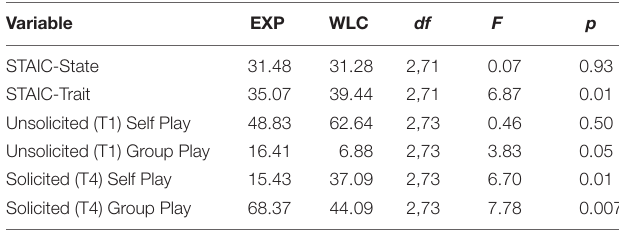
TABLE 2 | Pretest-adjusted post-mean differences for play and anxiety